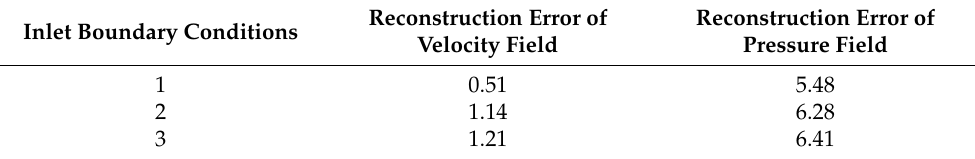
Table 3. Reconstruction errors (%) of velocity and pressure fields under three different wind shear